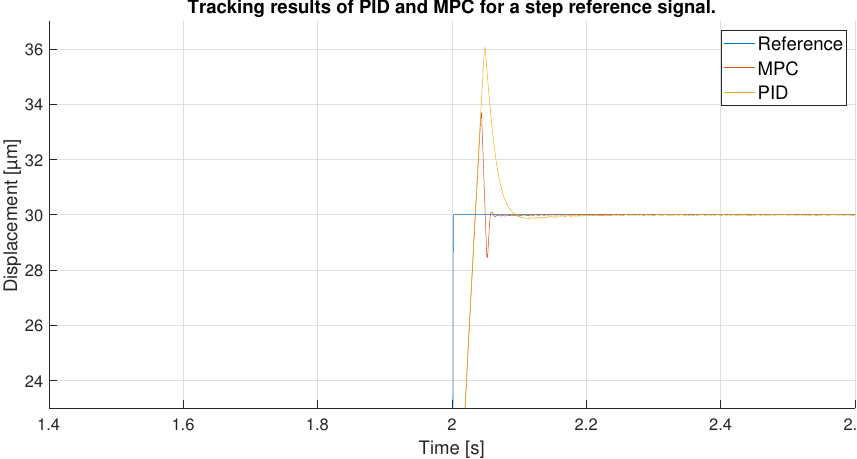
Figure 29. Zoom in of the tracking results in the reference change.